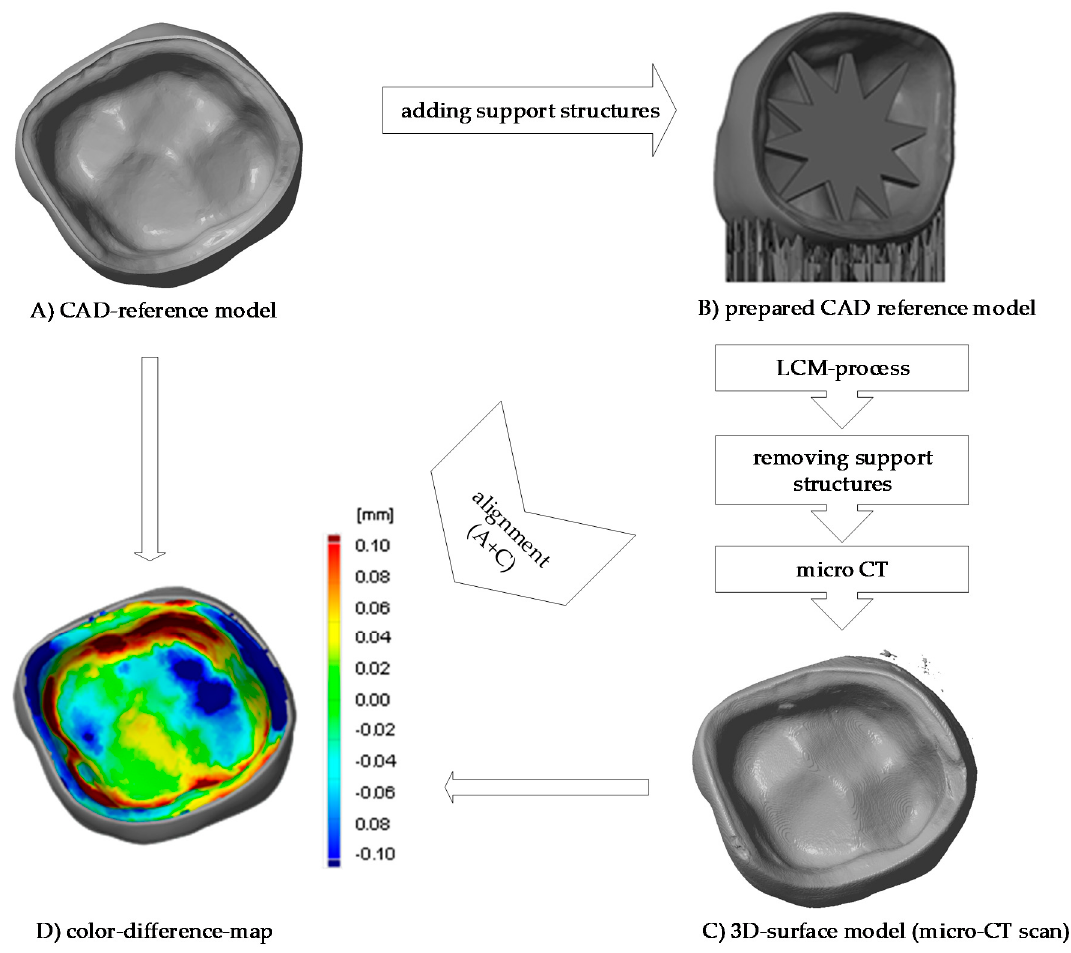
Figure 7. Procedure of evaluating the precision of the 3D-printed crown ( a ) CAD-reference model, ( b ) prepared CAD reference model, ( c ) micro-CT scan of 3D-printed and sintered molar crown,